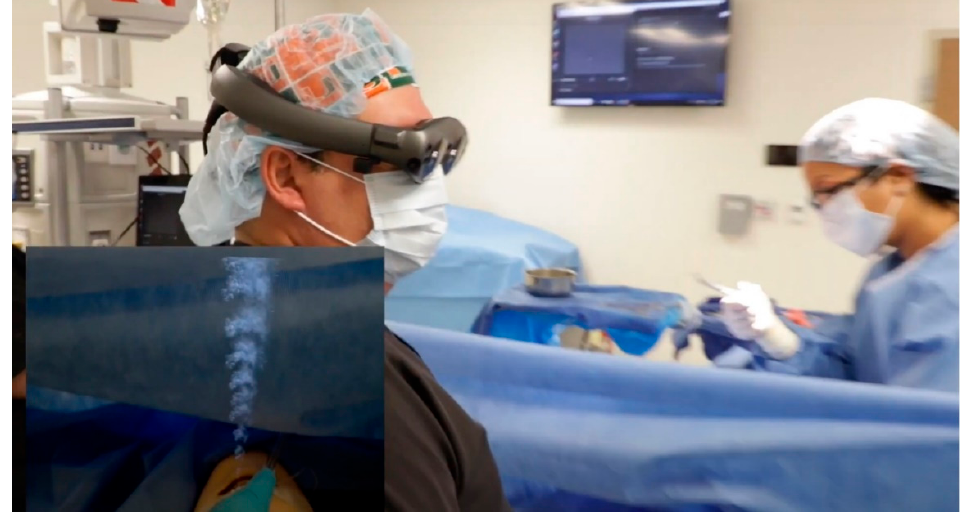
Figure 6. Student’s and instructor’s view of smoke from the airway. Source: University of Miami IT Department.